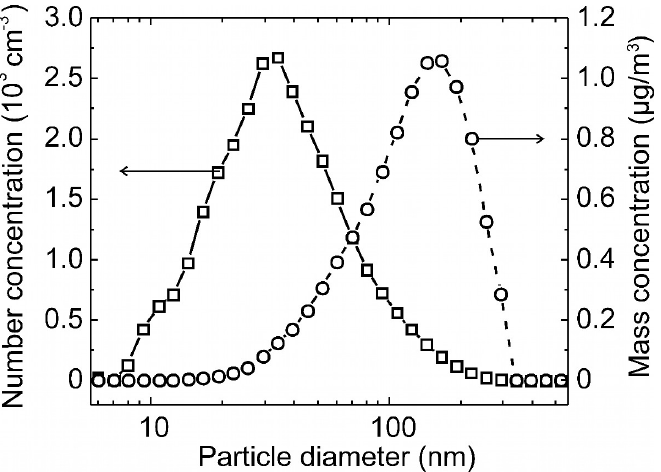
Figure 4. Average size distribution of a nebulized polydisperse carbon aerosol measured with fast mobility particle sizer (FMPS).